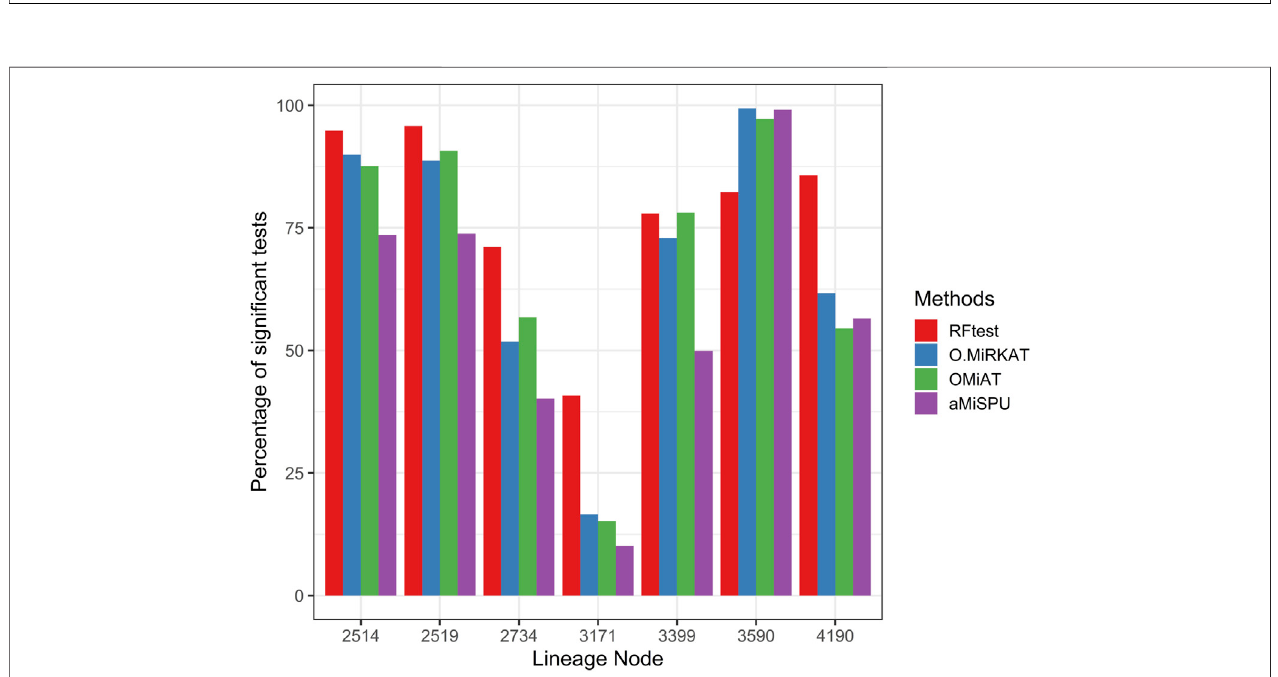
FIGURE 1 | Power comparison among the competing methods for a binary outcome variable under different signal types and densities. Abbreviation: O.MiRKAT, optimal MiRKAT. (A,B) Random signals with a density of 5% and 15%, respectively. (C,D) Phylogenetically clustered signal with a density of 5% and 15%, respectively.